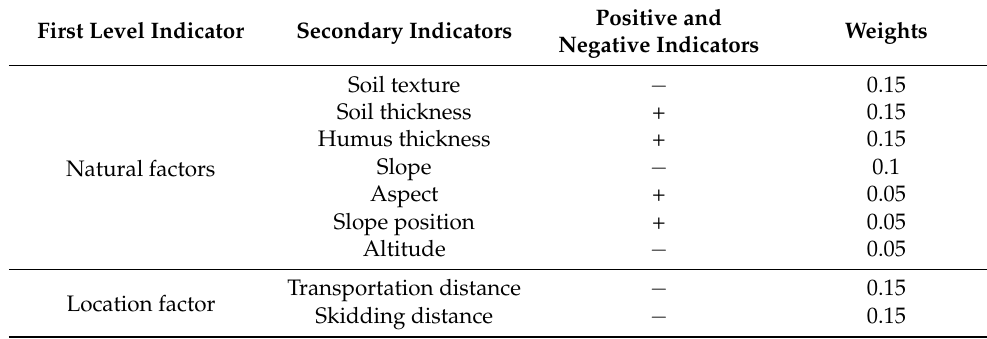
Table 1. The forest land grading index and weight value in Longquan